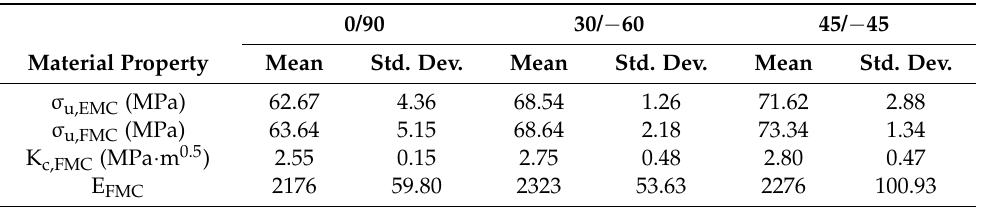
Figure 6. Load-displacement curves of the AM ABS for the three different raster orientations. Table 3. Properties of the virtual (brittle) material according to EMC and FMC for the different raster